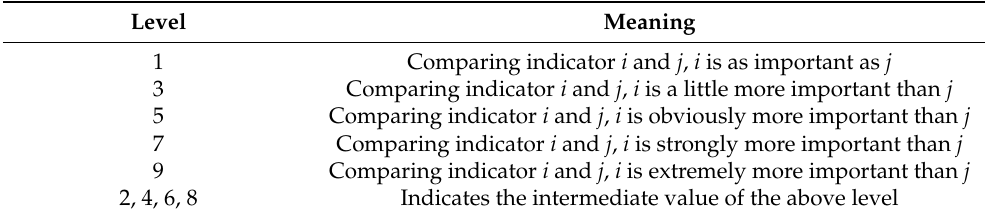
The judgment matrix of evaluation indicators using Saaty 9-level scale method (source: